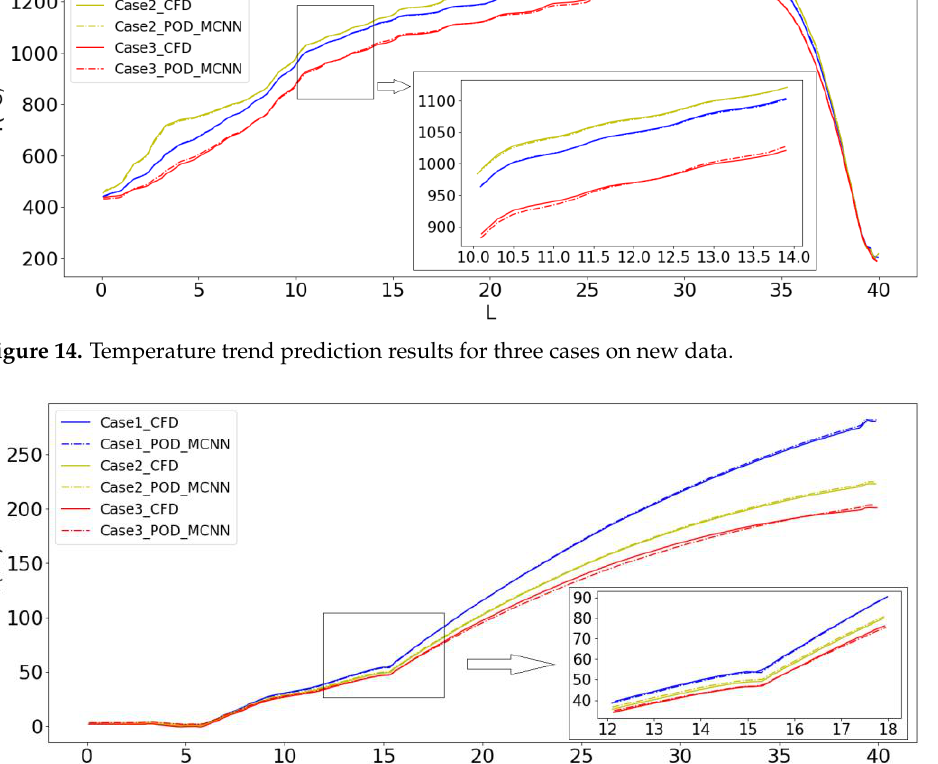
Table 4. Fault location for three cases. Figure 15. Pressure trend prediction results for three cases on new Figure 15. Pressure trend prediction results for three cases on new data.